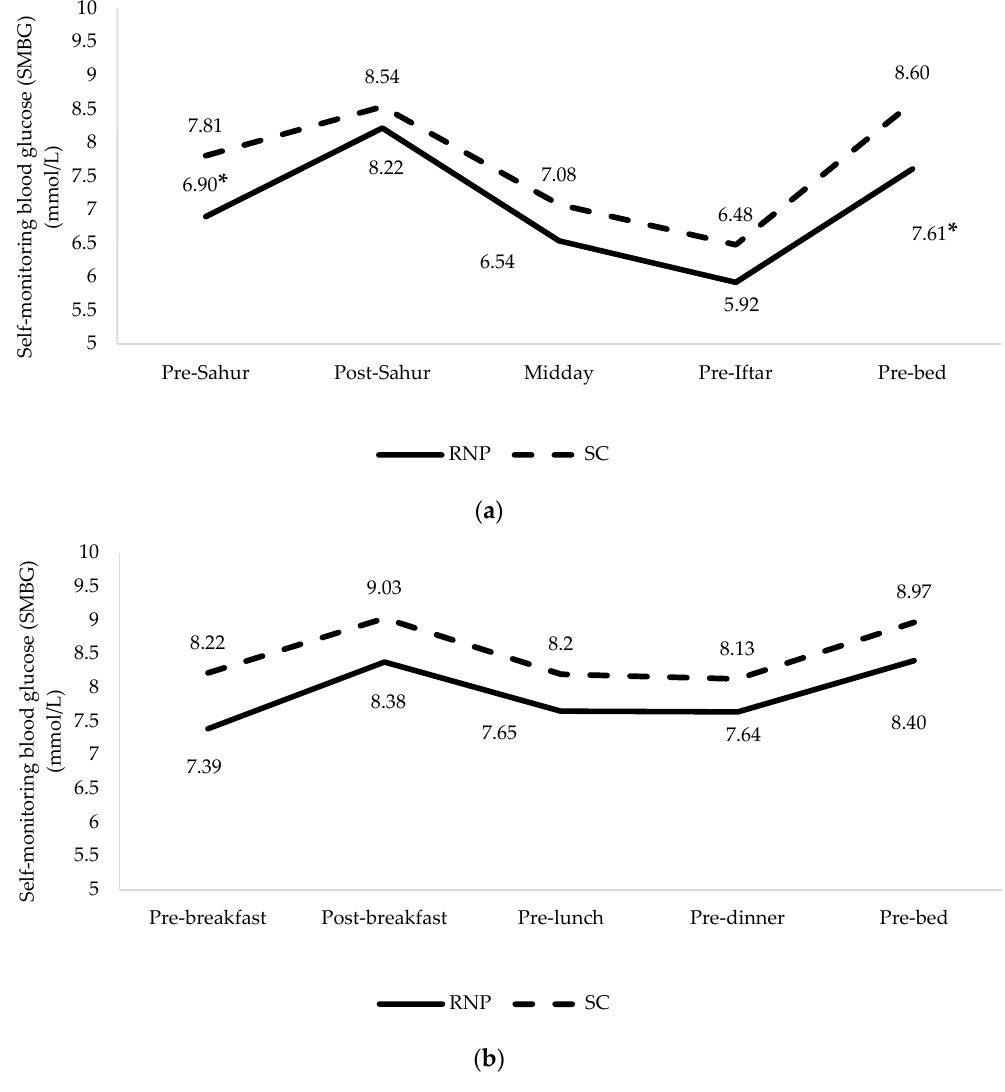
Figure 3. Self-monitoring blood glucose (SMBG) profiles between sRNT and SC, during. ( a ) Ramadan, ( b ) post-Ramadan, * Statistically significant differences between groups.